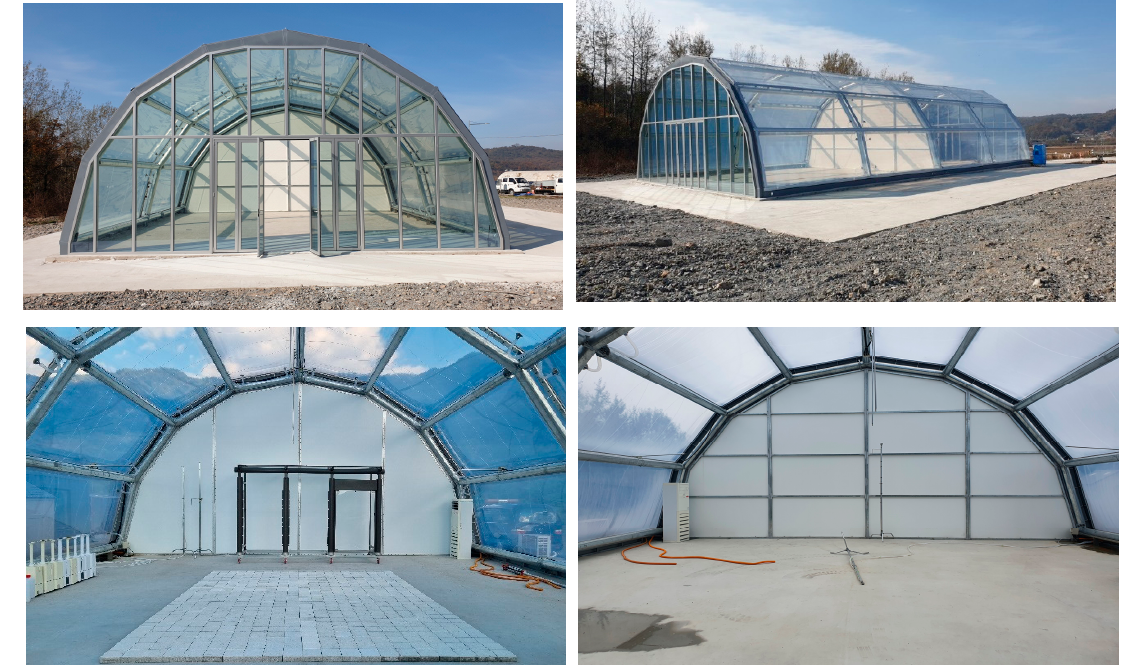
Figure 8. KICT Full-Scale Environment Chamber.